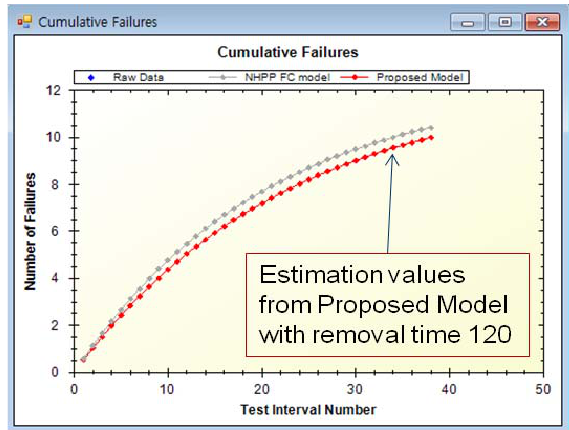
Fig. 10. Estimation Values of the Goel-Okumoto Model